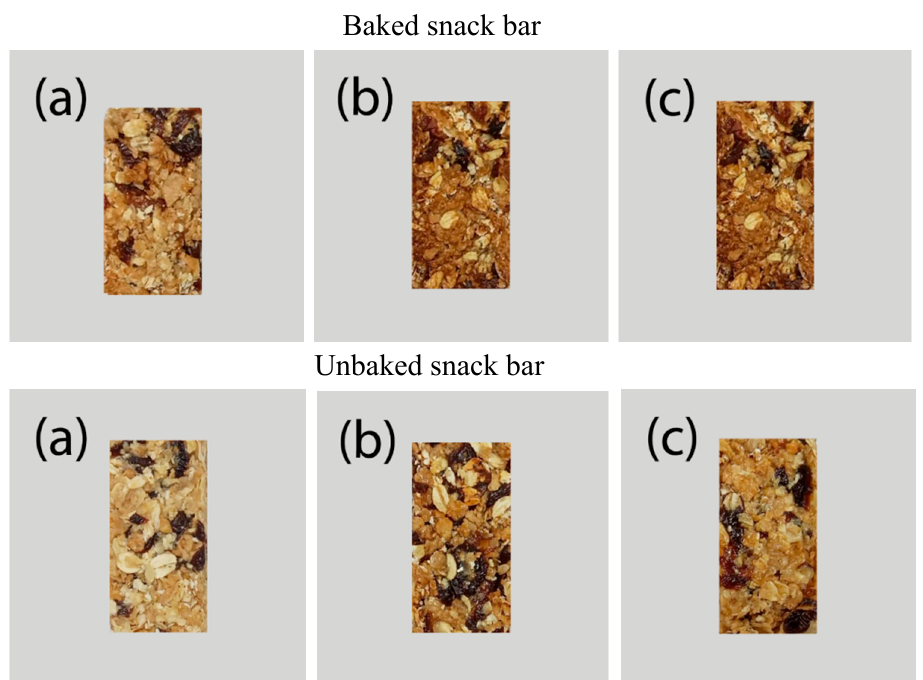
Figure 2. Photograph of snack bars with different substitutions of tilapia by ‐ product powder. ( a ): original snack bars/ control (SB); ( b ): snack bars with tilapia dry powder (SB + TDP); ( c ): snack bars with tilapia hydrolysate powder (SB+ THP). Table 3. Color analyses of snack bar products.